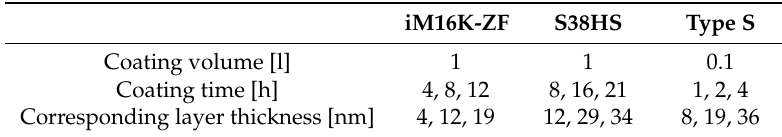
Table 2. Coating parameters of the aluminum coated glass spheres via Physical Vapor Deposition (PVD) at the University of